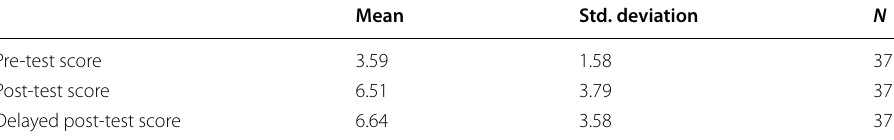
Table 5 Descriptive